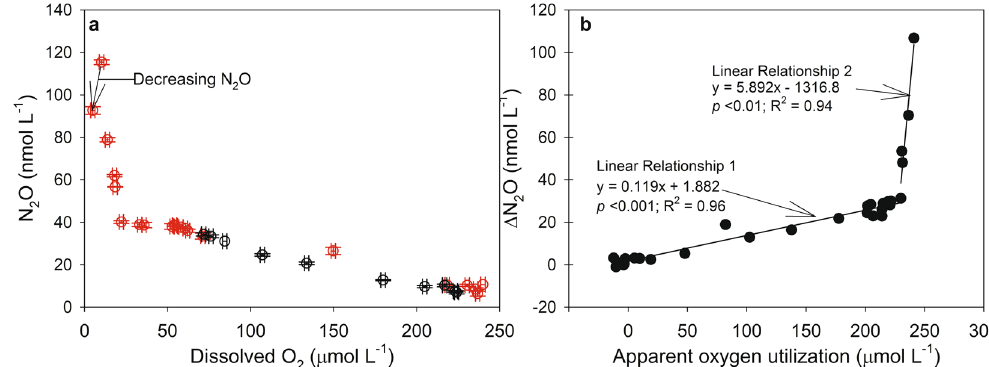
Figure 4. Relationship between nitrous oxide and dissolved oxygen (DO) parameters. ( a ) Nitrous oxide vs. DO concentrations from ES1 and ES2 (red circles) and from OES (black circles). The x-axis error bars represent the average propagation of error associated with our DO measurements (see Methods section) and the y-axis error bars represent the standard deviation of duplicate N 2 O concentration measurements. ( b ) Δ N 2 O vs. apparent oxygen utilization (all data pooled; note: data point from the DO minimum at ES2 where the N 2 O concentration decreased is omitted). The solid lines are linear regressions and the results from the linear regression analyses are